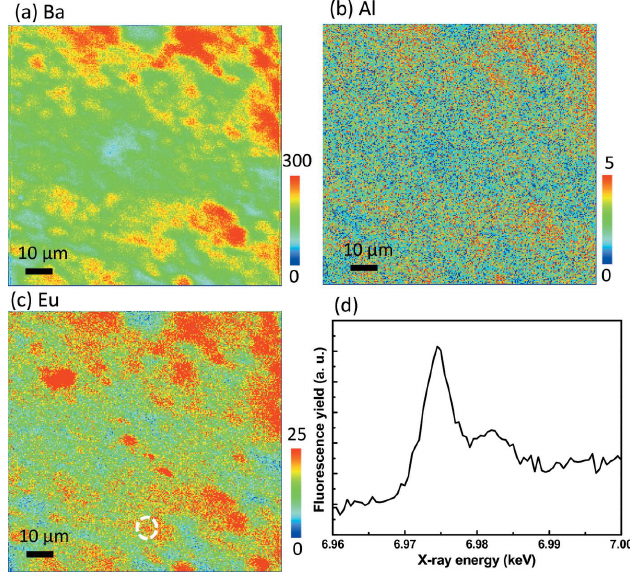
Figure 1 XRF maps of Eu-doped BaAl 2 O 4 , showing the elemental distributions of ( a ) Ba, ( b ) Al and ( c ) Eu. ( d ) X-ray absorption spectrum of the location marked with the white dashed circle in panel ( c ). On the basis of features of the Eu 2+ and Eu 3+ ions, XAS can reveal the corresponding amounts of the Eu 2+ and Eu 3+